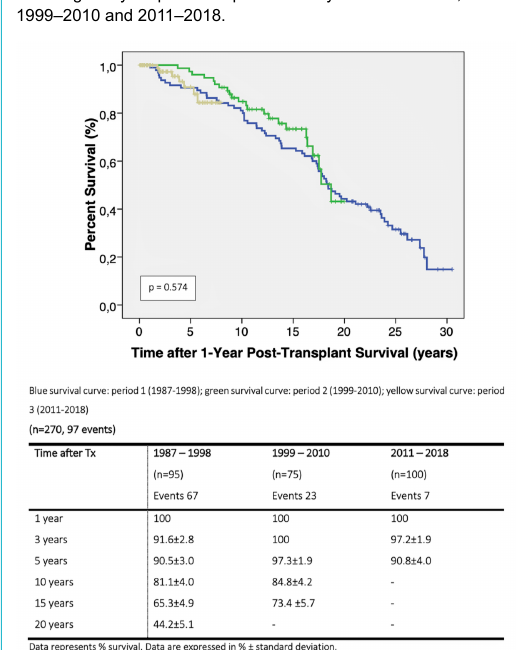
Figure 3: Kaplan-Meier estimate of all-cause mortality of patients surviving at 1 year post-transplant for the years 1987–1998, 1999–2010 and